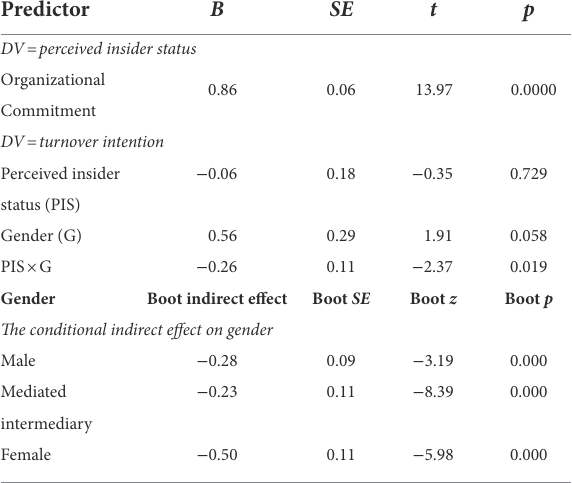
TABLE 4 Regression results for moderated effect.